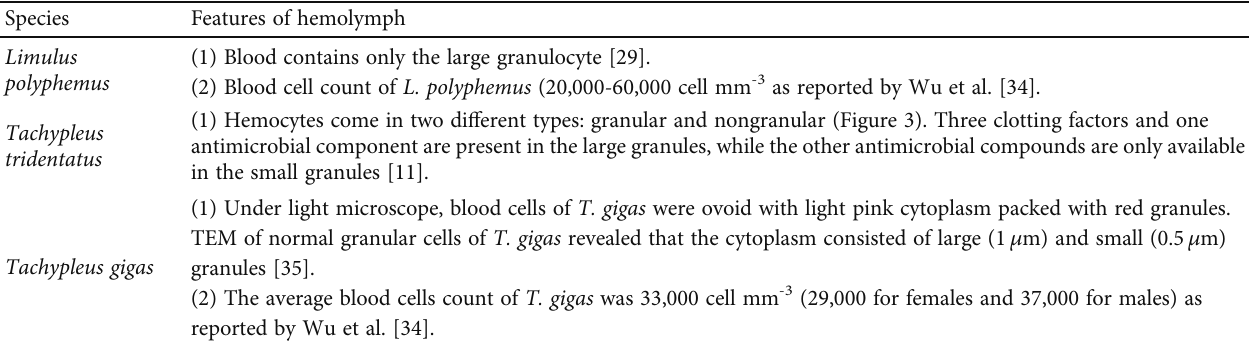
Table 2: Under the transmission and scanning electron microscopy (TEM and SEM) features of hemolymph of di ff erent species of horseshoe